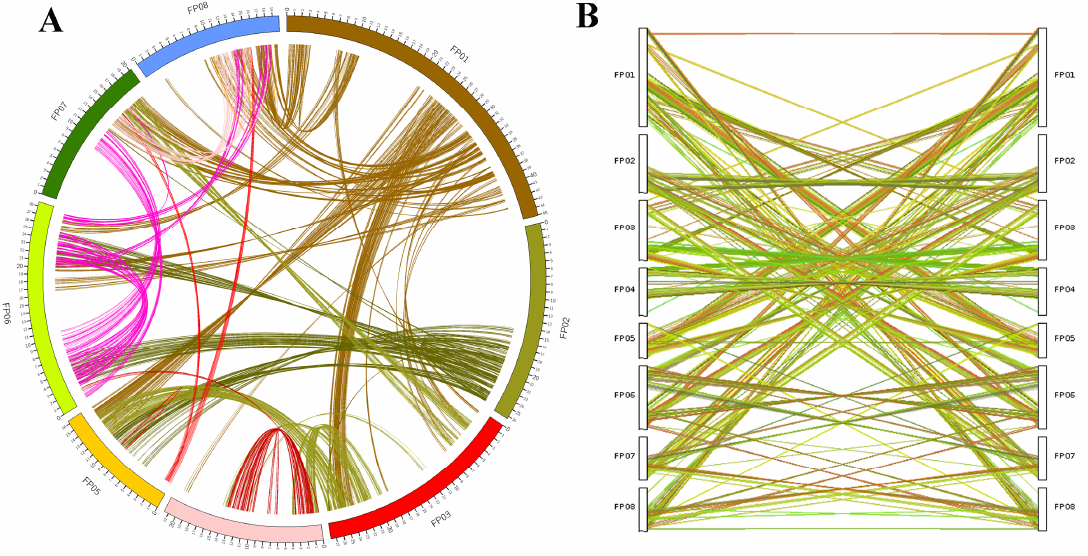
Figure 3. Self-collinearity of ‘124 Pan’ genome. ( A ) Circle plot of gene synteny within ‘124 Pan’ genome, different chromosomes and collinearities are distinguished by different colors. ( B ) Dual synteny of chromosome fusions within ‘124 Pan’ genome. Different collinearities are represented by different colors.